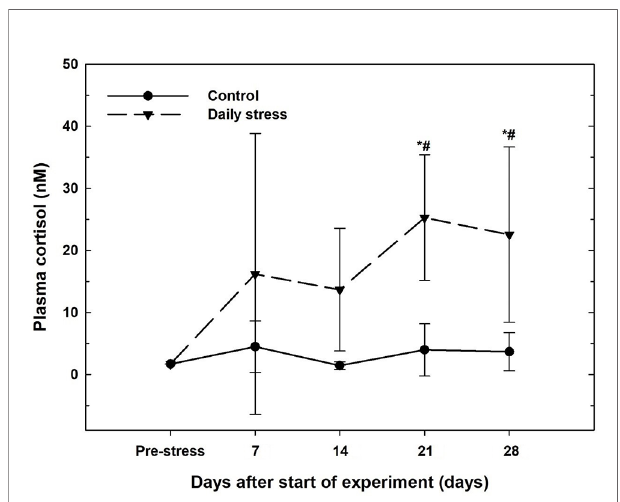
FIGURE 1 | Plasma cortisol levels (mean ± SD, n = 6) in the control group ( fi lled circles) and daily stress group ( fi lled triangles) in lump fi sh during the 28 day trial. # indicates signi fi cant difference between groups at the same sampling day at 95% con fi dence level, * indicates signi fi cant difference from the pre-stress level at 95% con fi dence